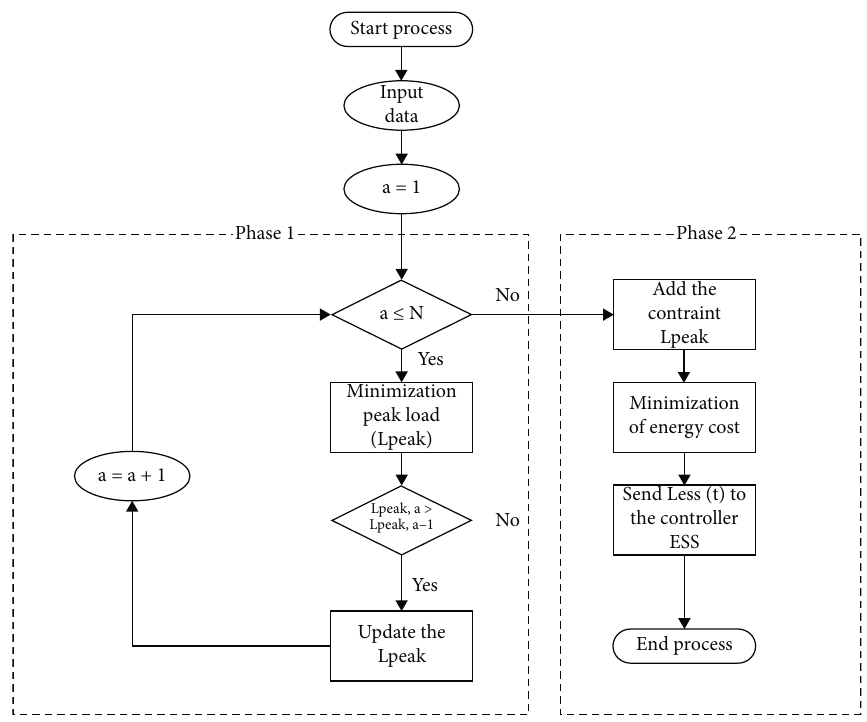
Figure 4: Flowchart of ESS optimization